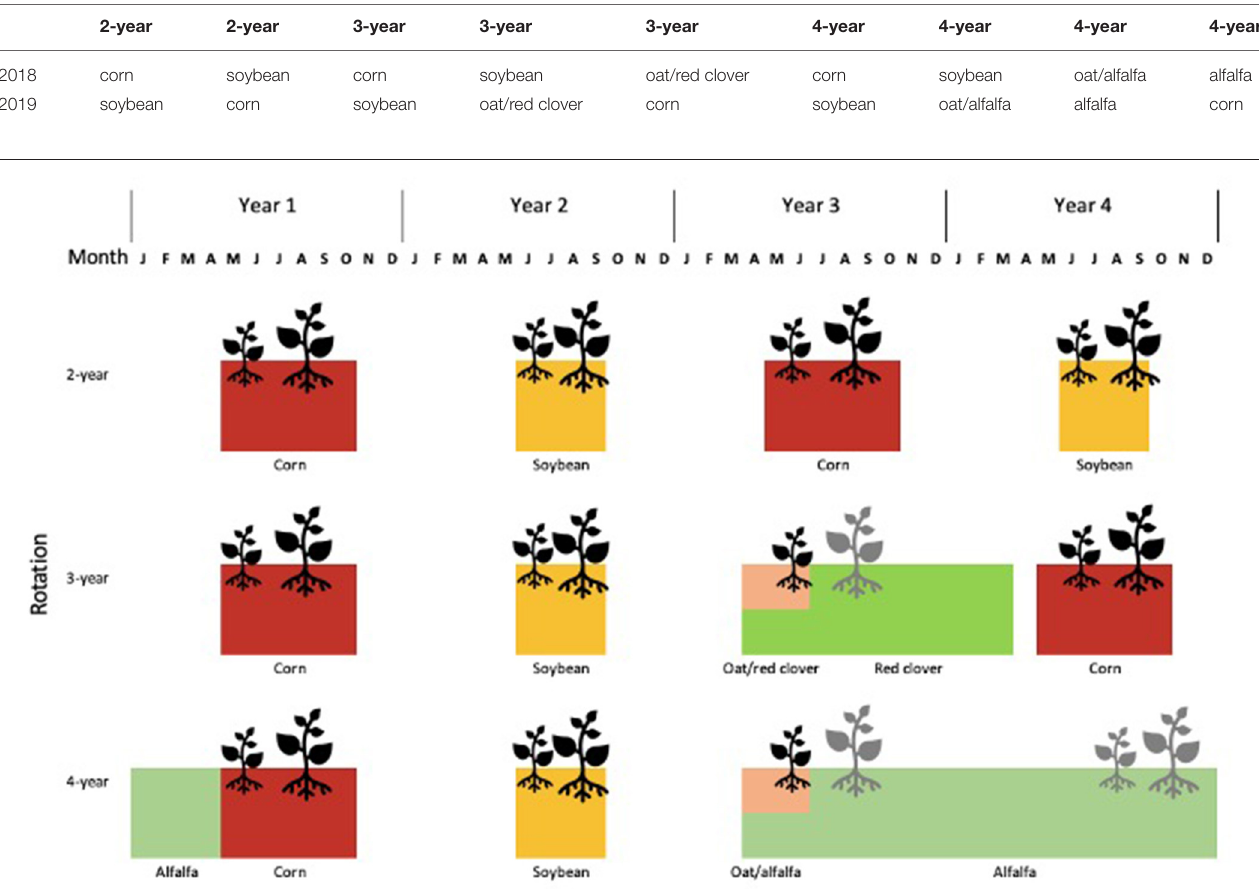
TABLE 1 | Crop phases of the three rotation systems present in a replicate block in 2018 and 2019.